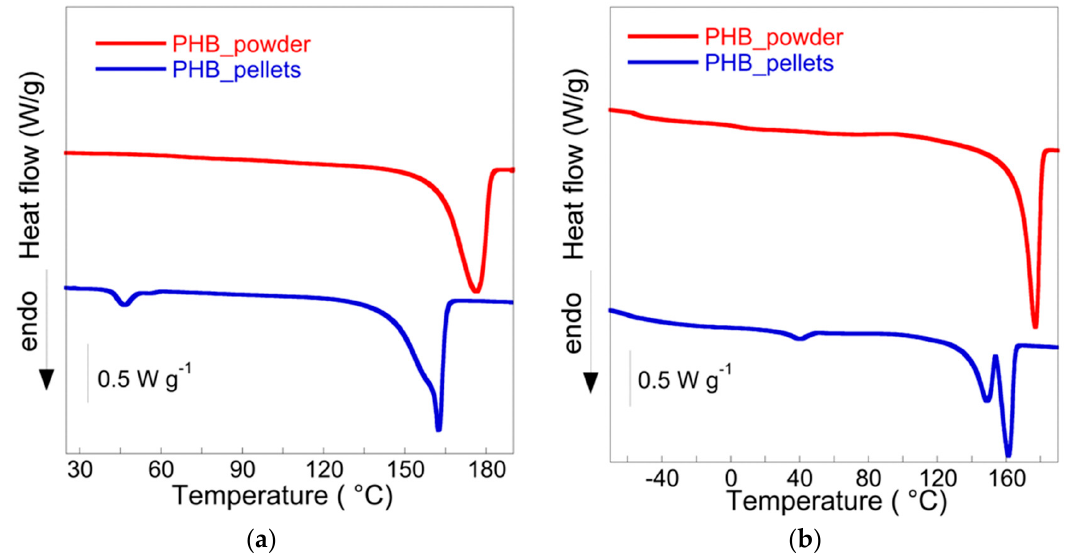
Figure 5. ( a ) First heating scan and ( b ) second heating scan of PHB powder and pellets.